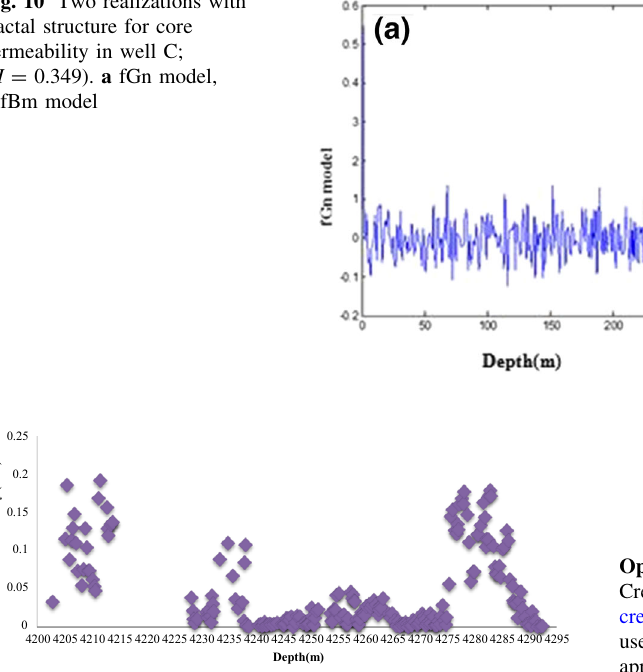
Fig. 10 Two realizations with fractal structure for core permeability in well C;